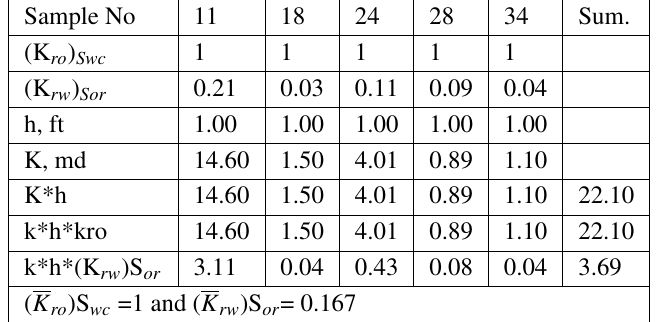
Table 2. Average relative permeability at S wc &S or for Upper Bahariya reservoir